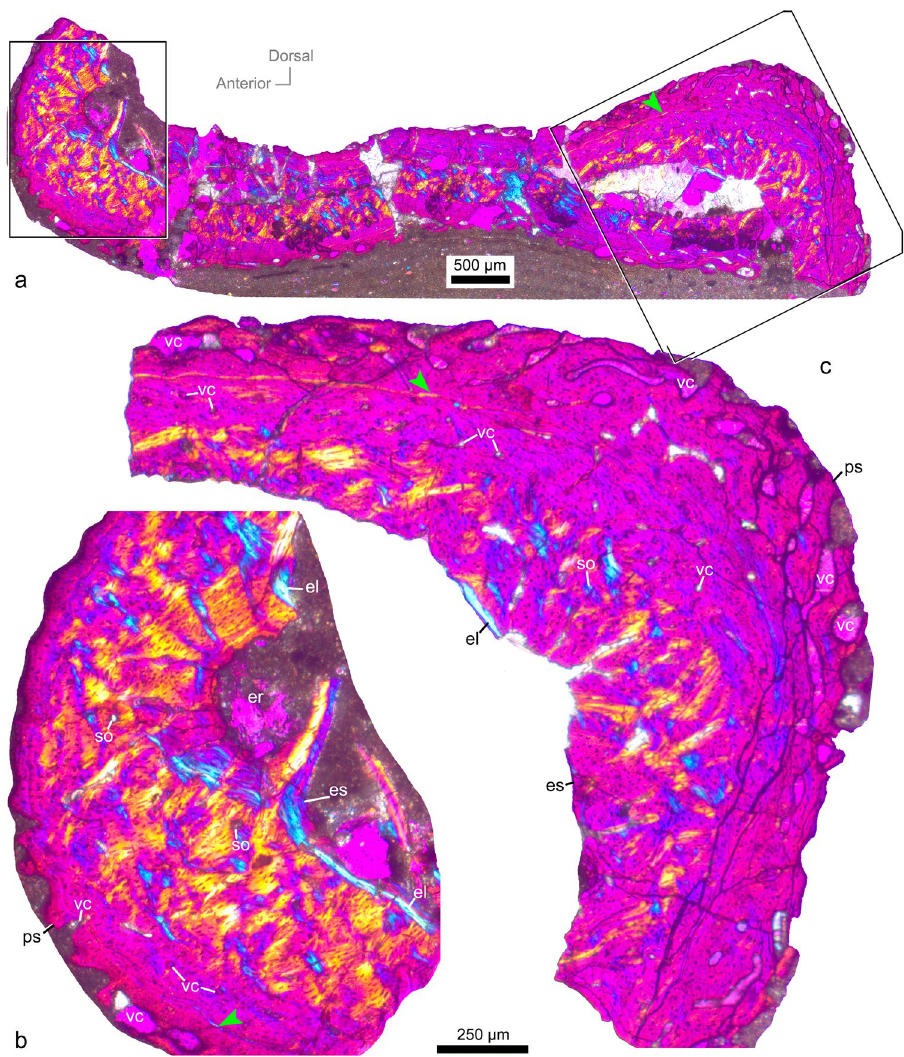
Figure 3. Histological thin-section of the first wing phalanx (SDUST-V1014; 30 µm in thickness). Whole cross section ( a ) and enlarged image ( b , c ) under cross-polarized light. Arrow points to LAG. el endosteal lamella, er erosion room, es endosteal surface, ps periosteal surface, so secondary osteon, vc vascular